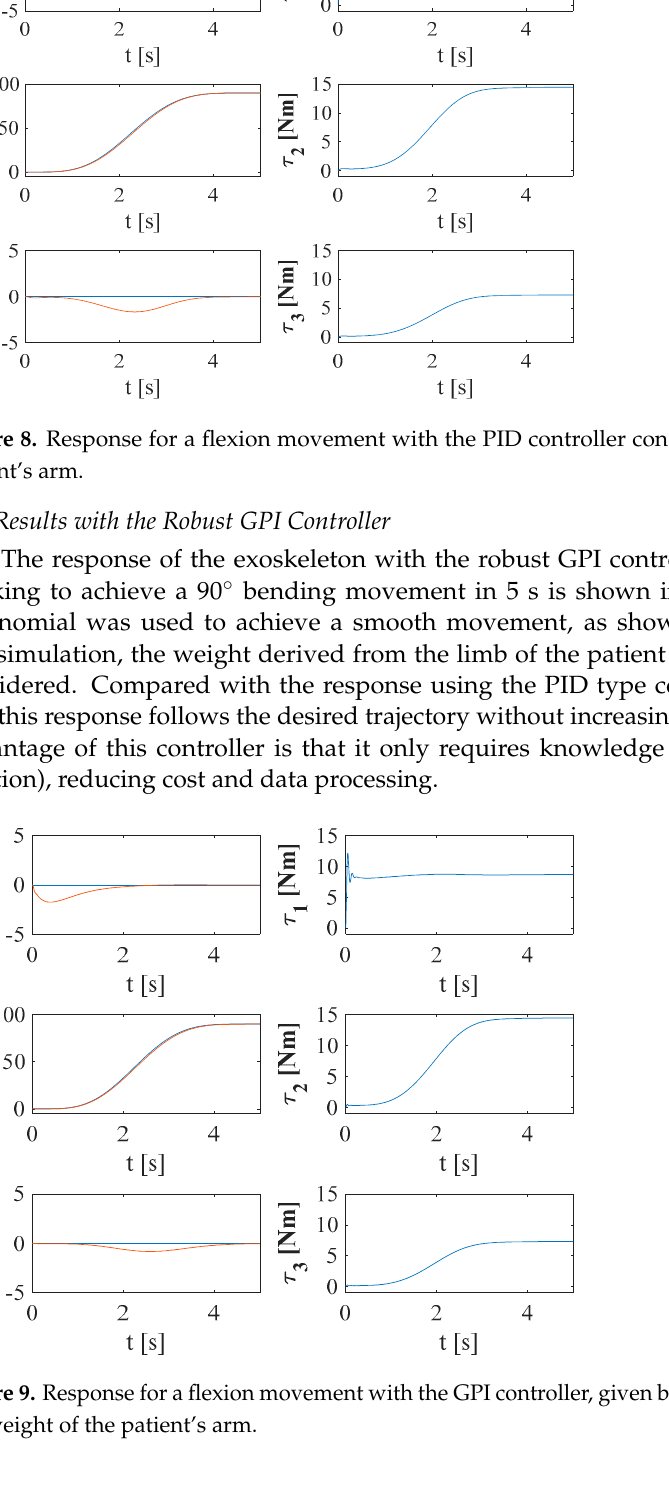
Figure 7. Response for a flexion movement without considering the weight of the patient’s arm.